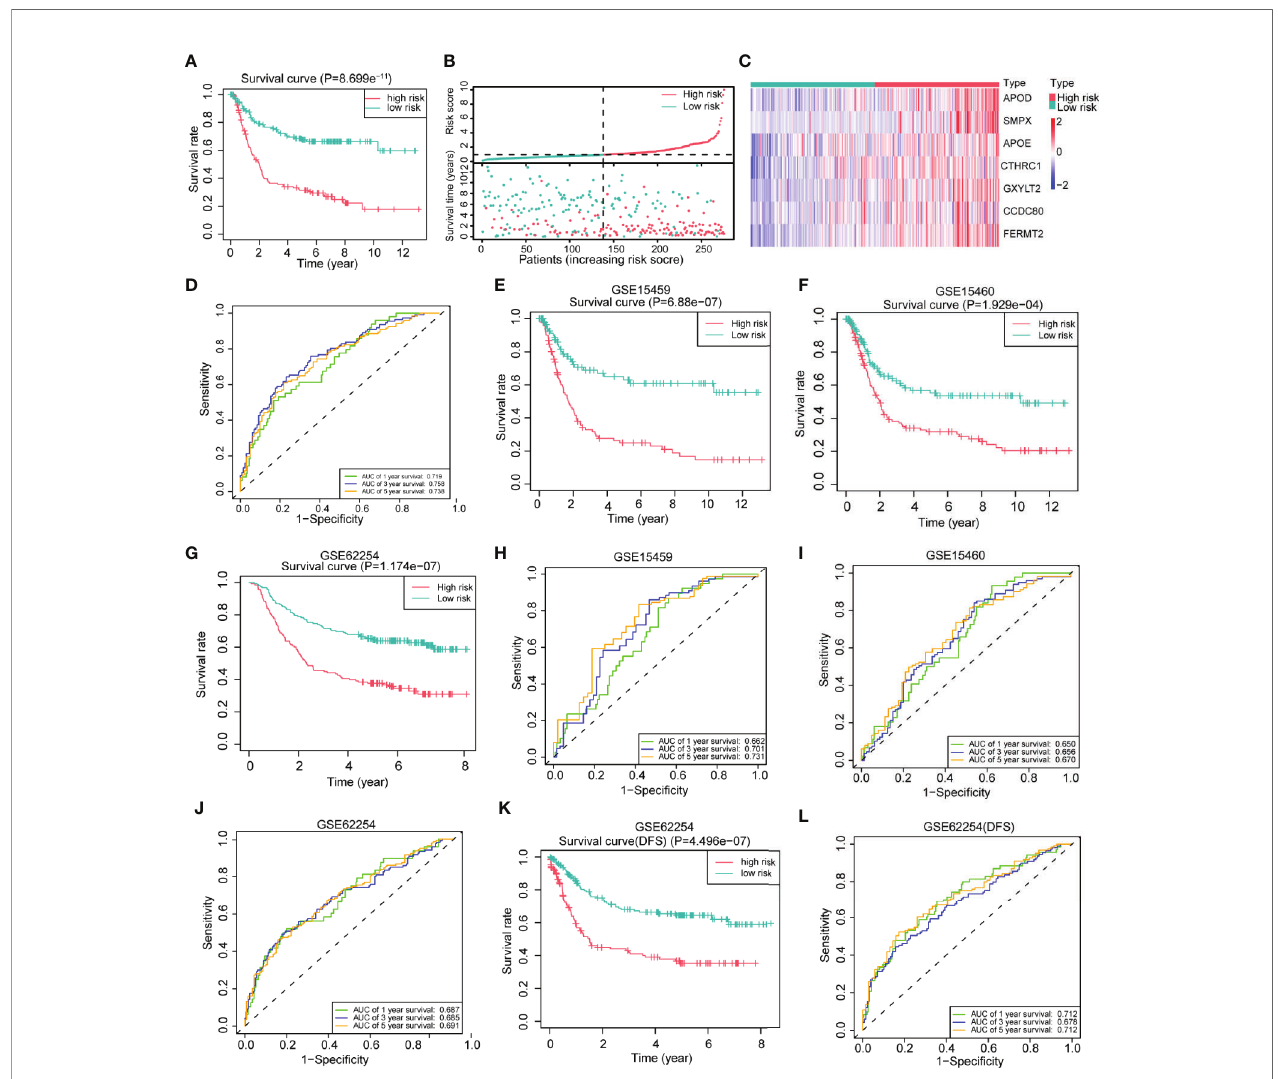
FIGURE 4 | Construction of a 7-gene signature for gastric cancer based on differentially expressed genes between the two clusters. (A) Kaplan – Meier survival analysis of the different patient risk groups (high-risk n = 138, low-risk n = 138; log-rank test). (B) The survival time, survival status and risk score of patients in different risk groups (high-risk n = 138, low-risk n = 138). (C) Heatmaps of the expression of the seven model genes in different risk groups of patients (high-risk n = 138, low-risk n = 138). (D) Time-dependent receiver operating characteristic (ROC) analysis of the risk score in gastric cancer patients. (E) An overall survival curve was drawn for the GSE15459 datasets based on the same cutoff value used to obtain the training set risk score (high-risk n = 100, low-risk n = 92). (F) An overall survival curve was drawn in GSE15460 datasets based on the same cutoff value used to obtain the training set risk score (high-risk n = 127, low-risk n = 121). (G) An overall survival curve was drawn for the GSE62254 datasets based on the same cutoff value used to obtain the training set risk score (high-risk n = 138, low-risk n = 162). (H – J) Plot of time-dependent survival ROC curves in different datasets. (K) A disease-free survival (DFS) curve was drawn for the GSE62254 dataset according to the same cutoff value used to obtain the training set risk score (high-risk n = 138, low-risk n = 162). (L) Plot of the time-dependent ROC curve for DFS. The data for (A – D) are from the training set. Data for (E, H) are from the GSE15459 dataset; (F, I) are from GSE1540; and (G, J – L) are from the GSE62254